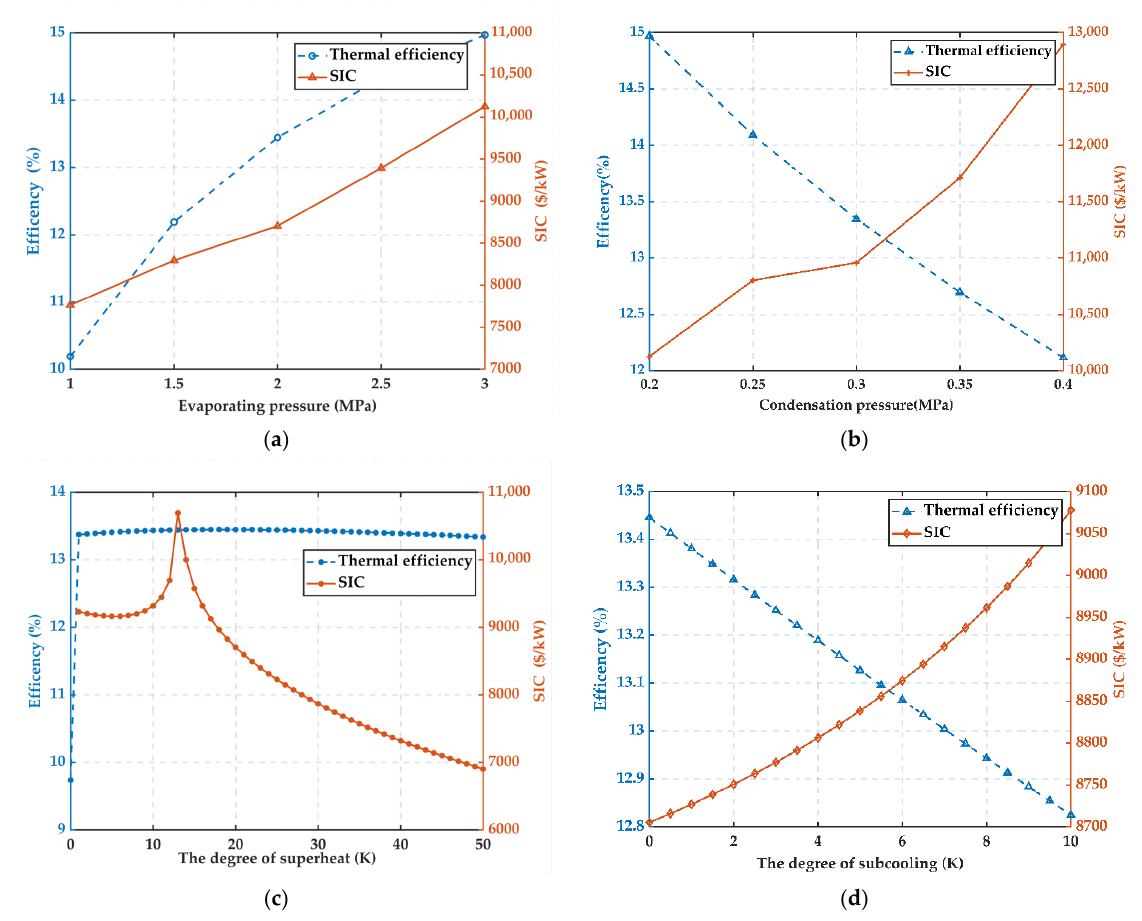
Figure 11. The effect of the ORC operating parameters on the two objectives with the engine speed of 2250 rpm at the full load: ( a ) evaporation pressure; ( b ) condensation pressure; ( c ) the degree of superheating; ( d ) the degree of subcooling.